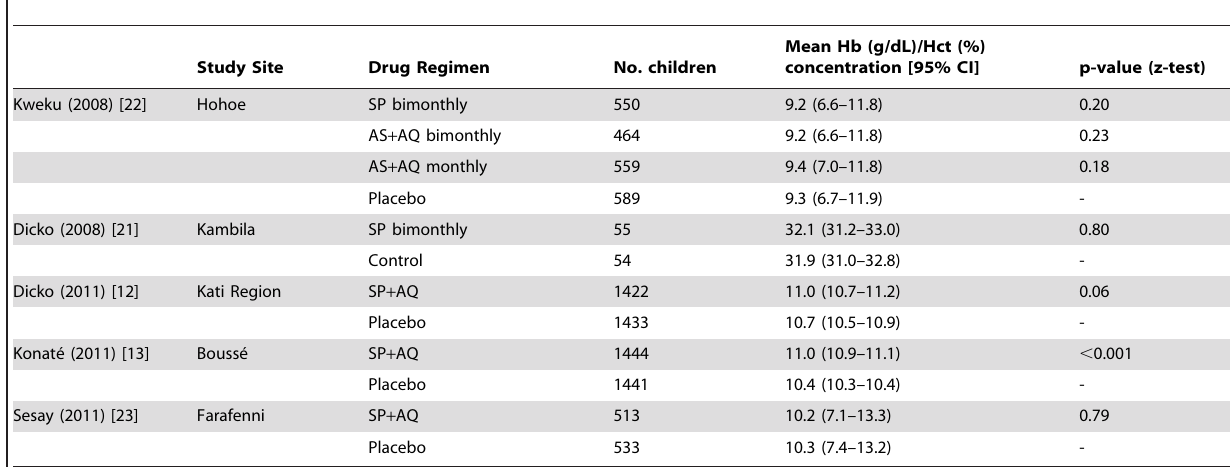
Table 5. Effect of IPTc on mean haemoglobin/haematocrit concentrations in intervention and control arms at the end of the intervention